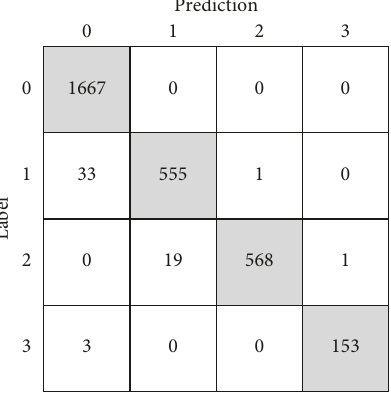
Figure 10: Misrecognition